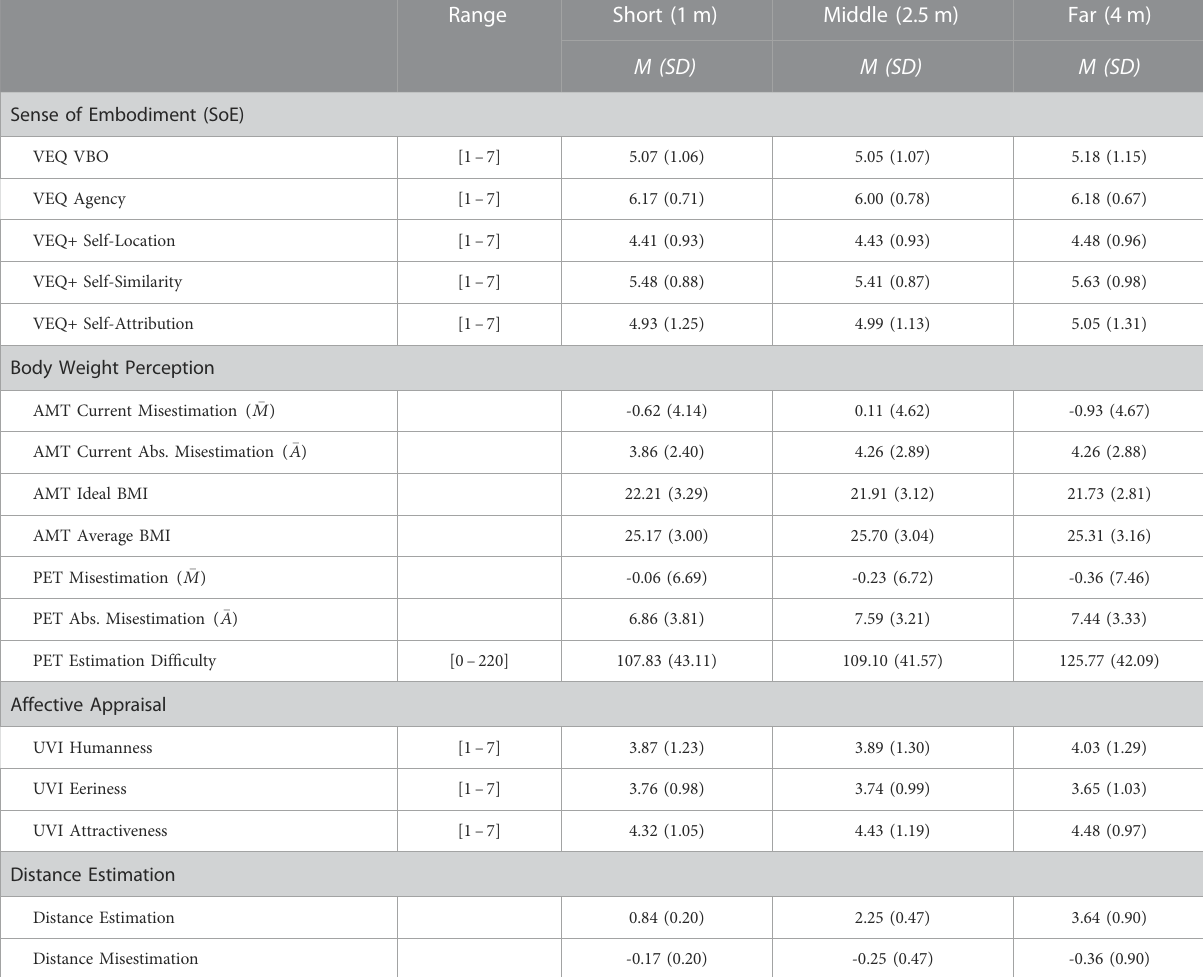
TABLE 2 Descriptive values of our measures that were compared between the different